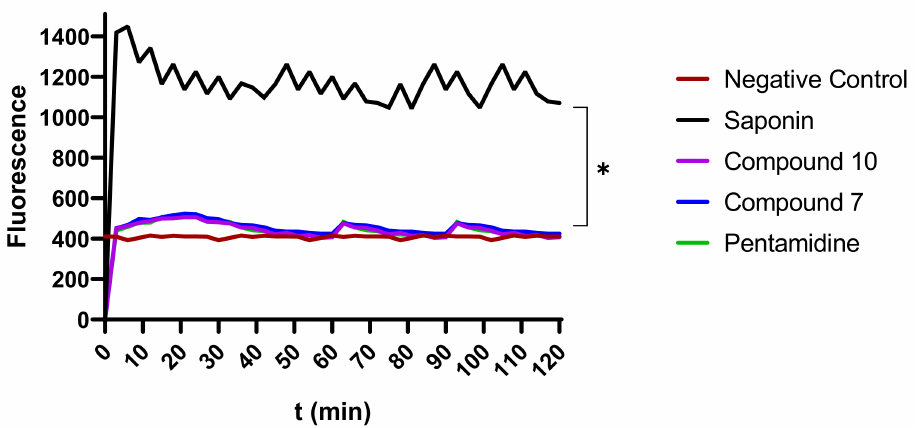
Figure 9. Depiction of the effect of inhibitors on membrane integrity. The fluorescence intensity of trypanosome DNA-SYBR Green (SG) complexion was measured over 120 min. Parasites at 2 × 10 6 cells/mL were preincubated with SG followed by treatment with compounds 7 and 10 at their IC 99 , IC 90 , IC 50 , and IC 10 for 120 min. SG uptake was then fluorometrically monitored, and data were obtained to plot corresponding curves versus time. The results were compared to the negative control and the positive control (* Significant difference at p < 0.05). Negative control (NC): trypanosomes untreated with inhibitors; Saponin: 100%